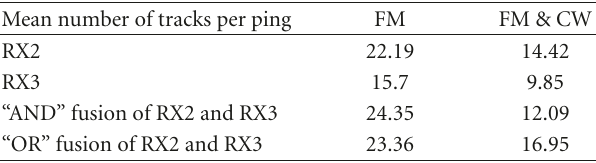
Figure 15: Comparison of tracking performance for two di ff erent algorithms: “situationally adaptive fusion of FM and CW contacts ( P D adaptive)” and ““AND” fusion of FM and CW contacts ( P D fixed)”. Calculations of performance metrics in (a) and (b) are made for the following values of the false alarm density (in # / 1000): 0 . 4, 0 . 6, 0 . 8, 1 . 0, 1 . 2, 1 . 4. Table 5: Run A56: comparison of false track